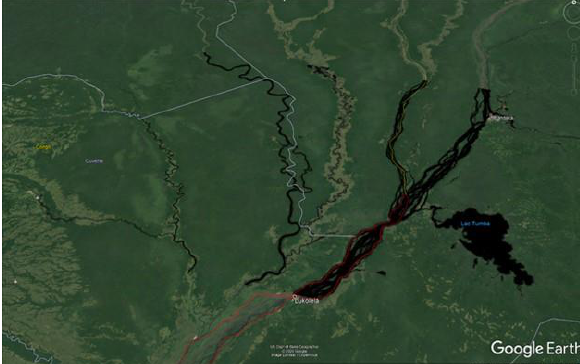
Figure 5: 20200303 VH binary classified image north of Lukolela. Common classifications are not removed in this image.